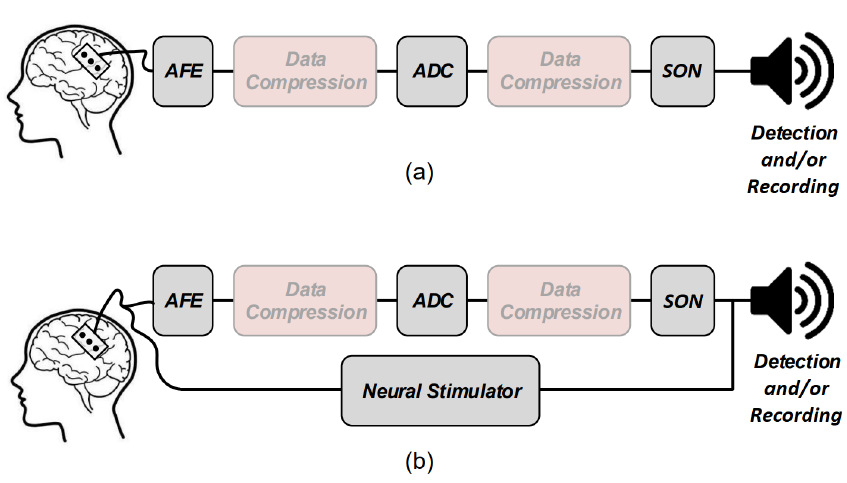
Figure 2. General overview of ( a ) a low-power seizure detection, and ( b ) a low-power seizure control